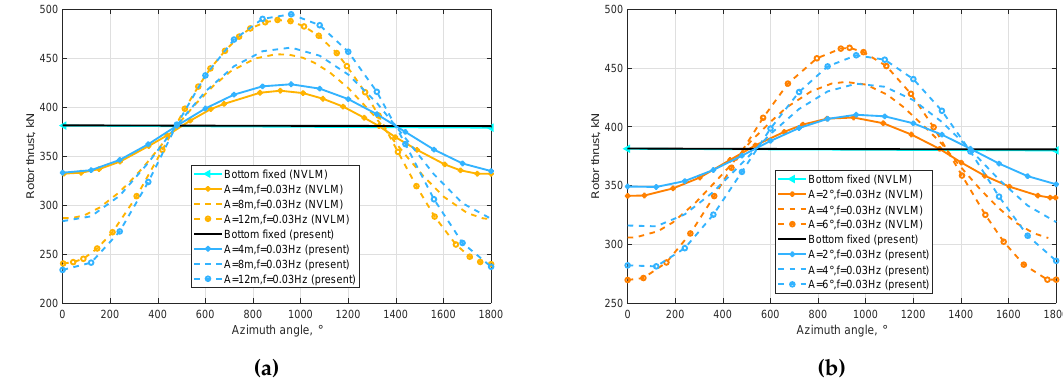
Figure 9. Thrust with: ( a ) surge ( A = 4 m, 8 m, 12 m, f = 0.03 Hz); and ( b ) pitch ( A = 2 ◦ ,4 ◦ ,6 ◦ , f = 0.03 Hz).